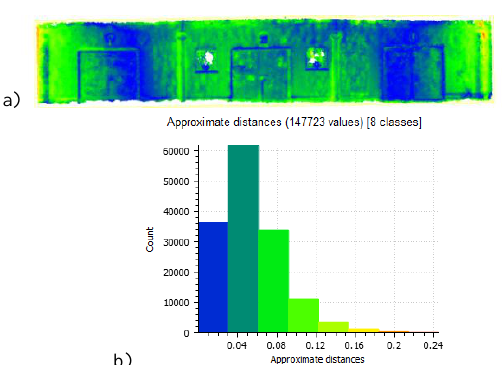
Figure 6. Exampled NURBS planes generated based on 3D model in the form of a mesh of the test object